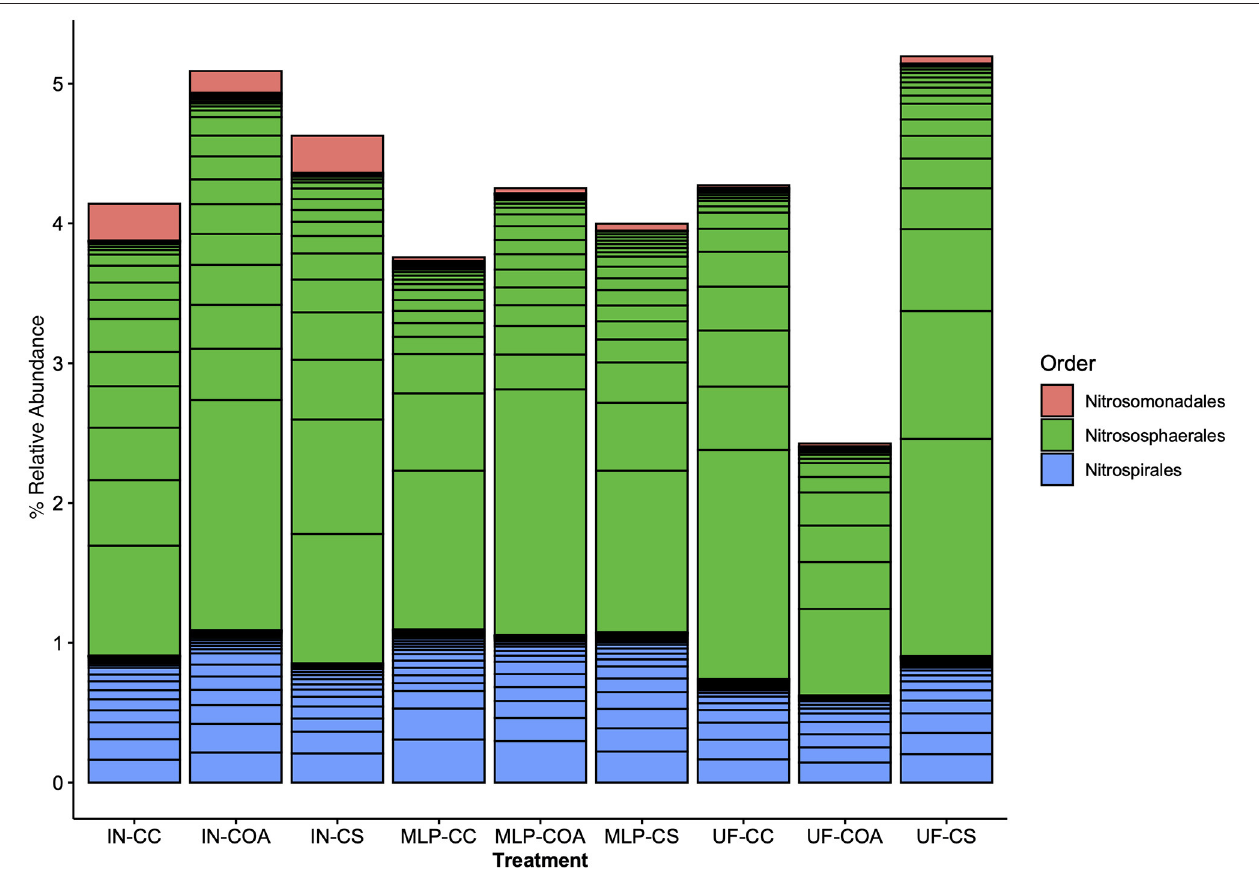
FIGURE 5 | Nitrifier composition compared among long-term agronomic management treatments, represented as percent relative abundance of the total bulk soil 16S rRNA-based community. The bulk soil bacterial 16S rRNA community was subset by nitrifier taxa (AOA, AOB, NOB). Results are represented here with color representing order-level taxonomic classifications: Nitrosomonadales (AOB), Nitrososphaerales (AOA), Nitrospirales (NOB). Fertilization and rotational treatments are as follows: manure-lime-phosphorus (MLP), inorganic urea fertilizer (IN), unfertilized (UF); corn-oat-alfalfa (COA), corn-soy (CS), continuous corn